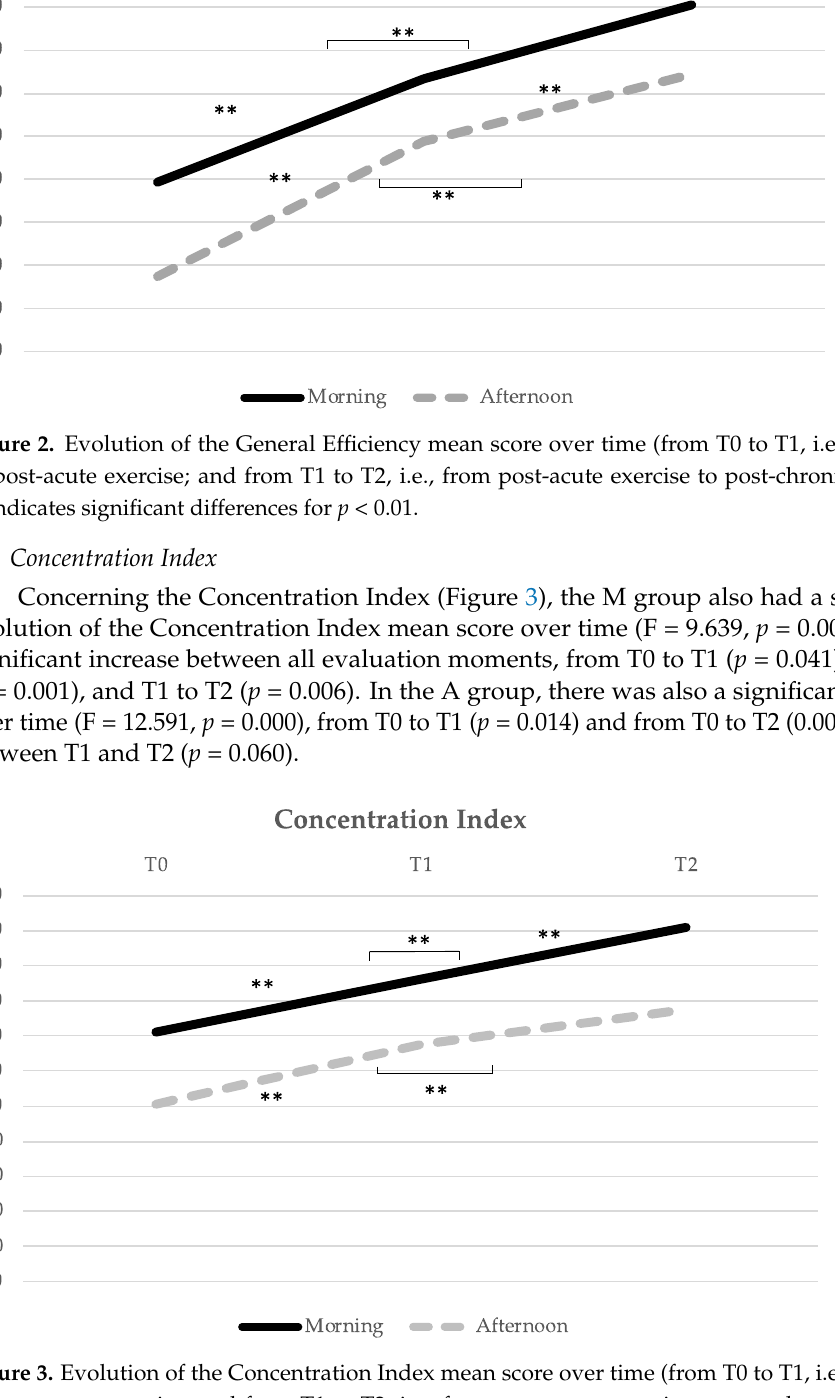
Figure 3. Evolution of the Concentration Index mean score over time (from T0 to T1, i.e., from pre- to post-acute exercise; and from T1 to T2, i.e., from post-acute exercise to post-chronic exercise). ** Indicates significant differences for p < 0.01.